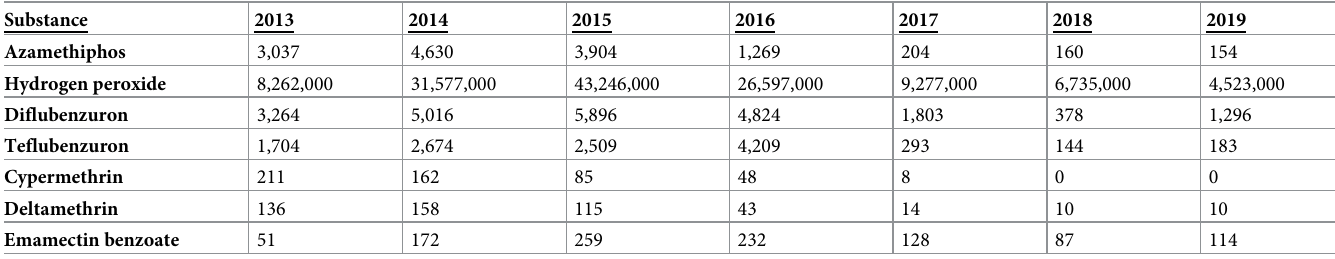
Table 2. Consumption of medicines, 2013–2019.